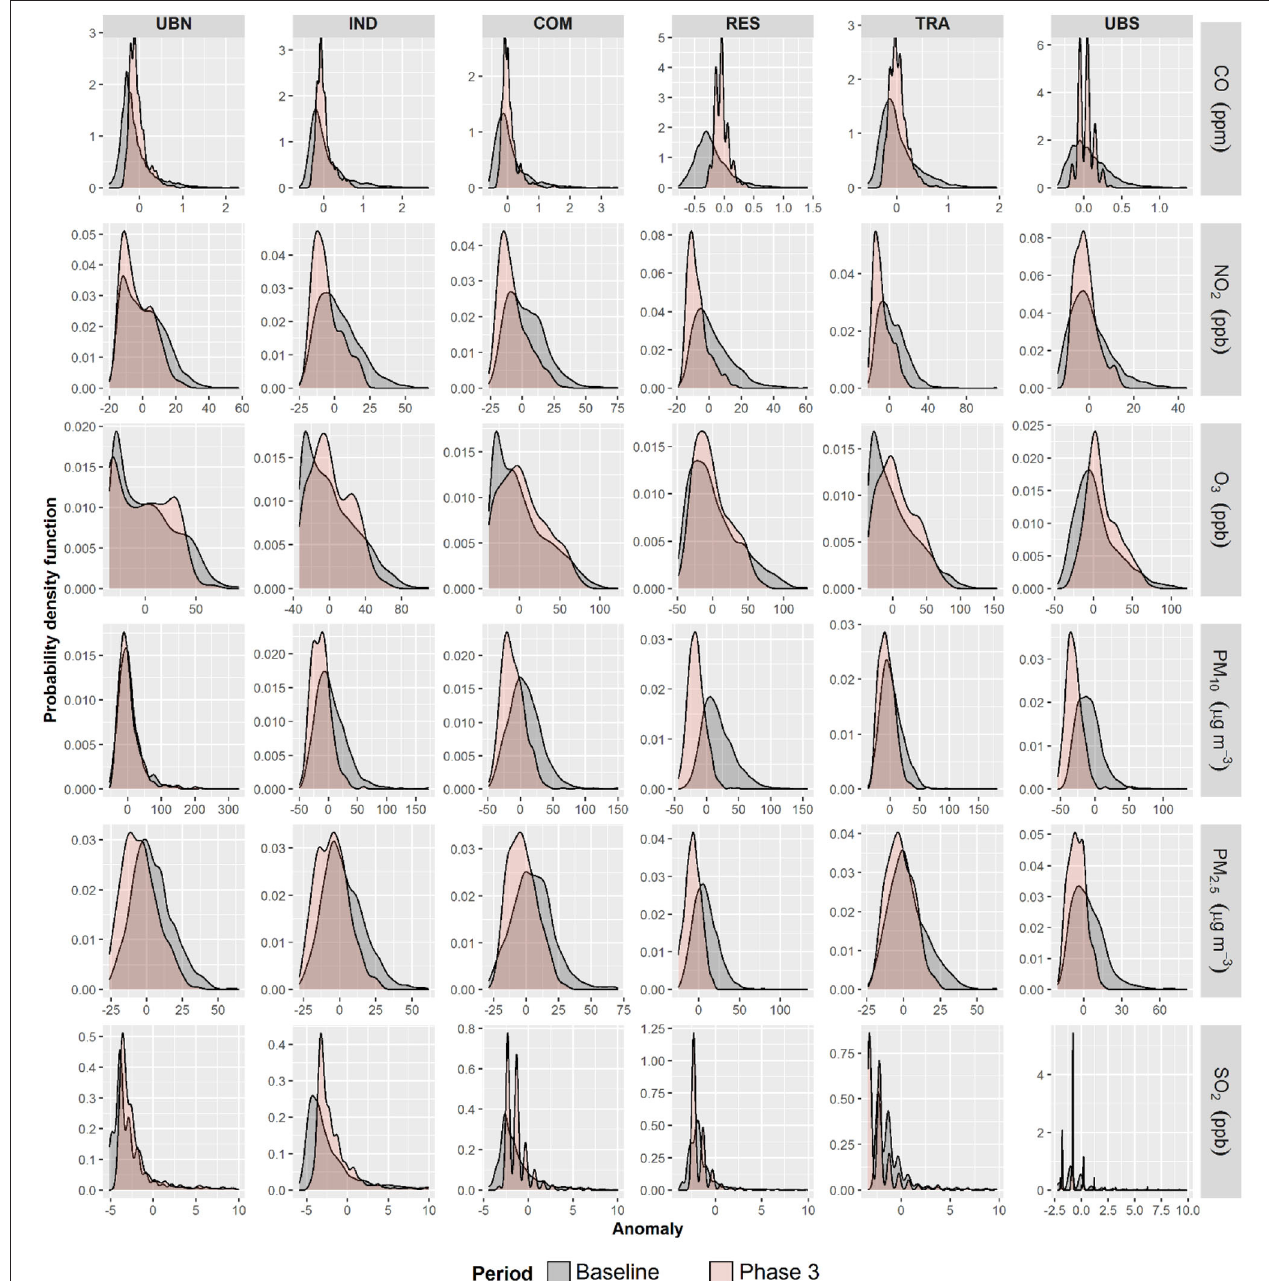
FIGURE 3 | Probability density function plots for hourly anomalies for CO, NO 2 , O 3 , PM 2.5 , PM 10 , and SO 2 during the COVID-19 lockdown Phase 3 and baseline within the